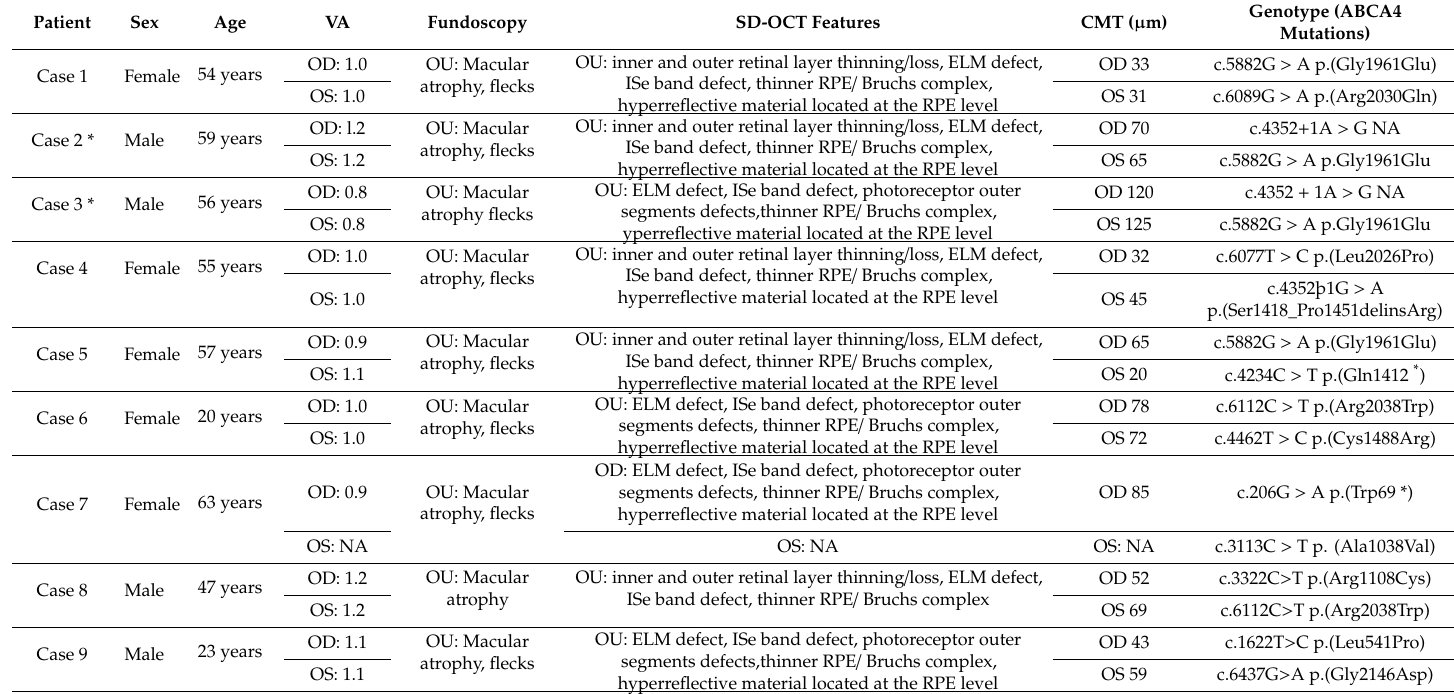
Table 1. Clinical and genetic characteristics of patients in this study with Stargardt disease